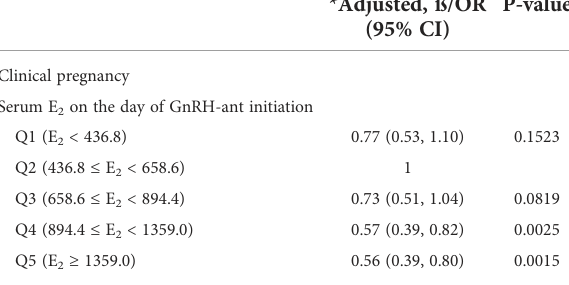
TABLE 3 Adjusted effect of the serum E2 level on the day of GnRH- ant initiation on clinical